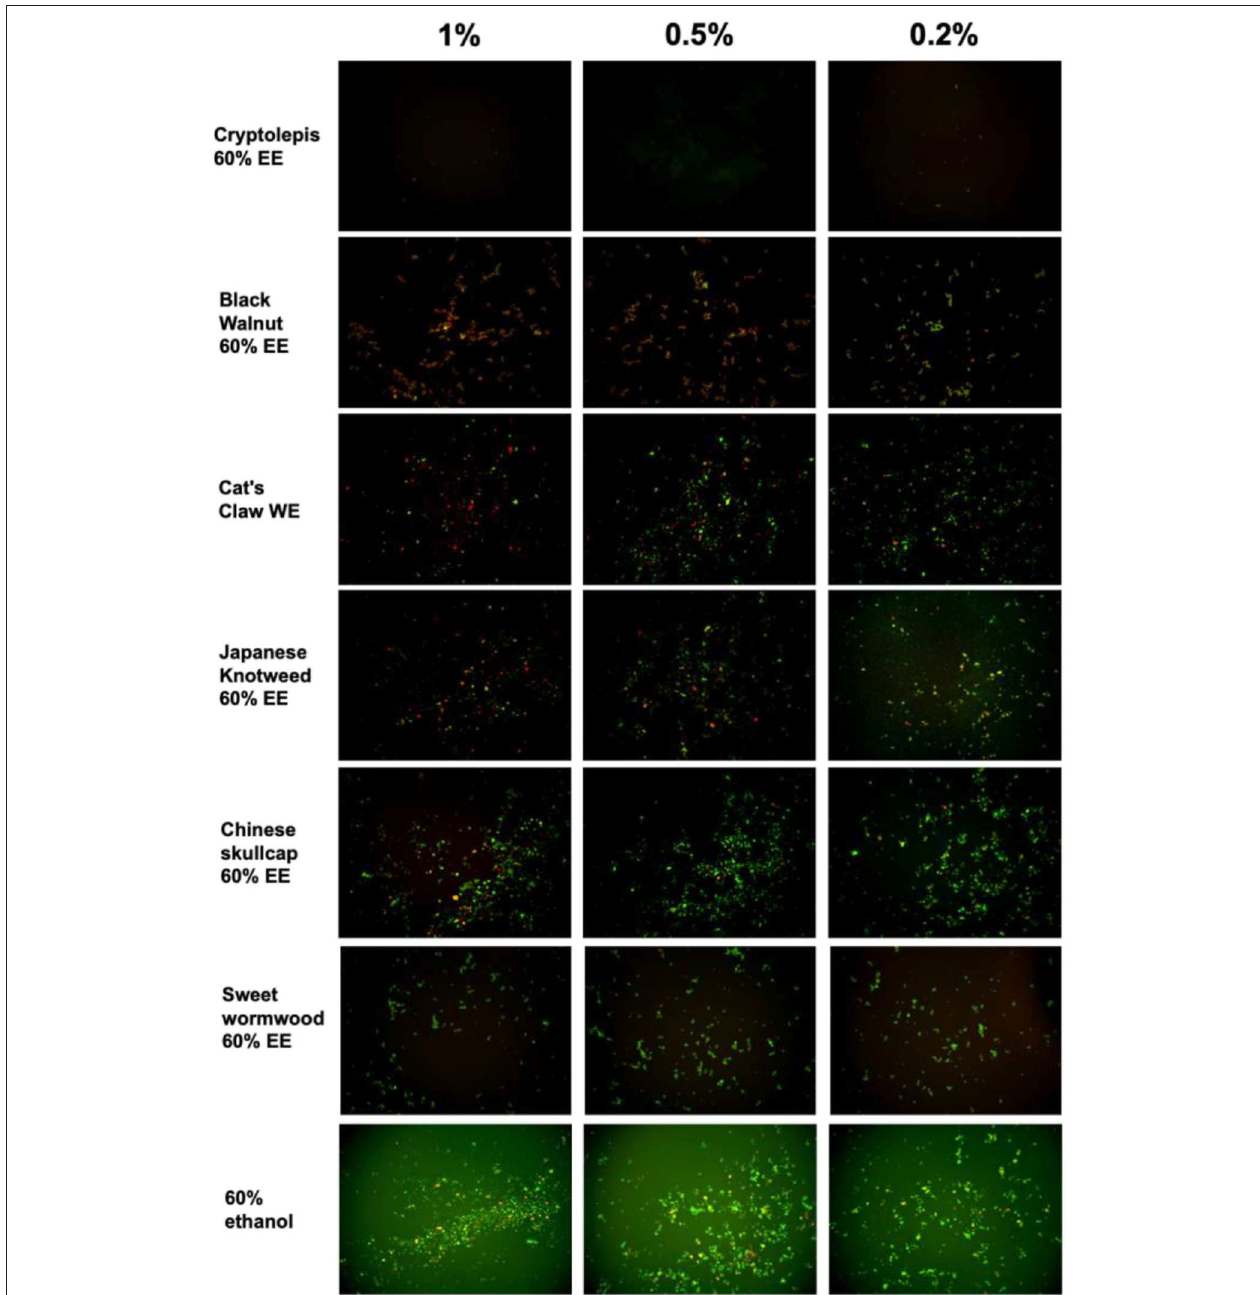
FIGURE 1 | Effect of natural product extracts on the viability of stationary phase B. burgdorferi. A 7-day old B. burgdorferi stationary phase culture was treated with the natural product extracts at 1, 0.5, and 0.2% for 7 days followed by staining with SYBR Green I/PI viability assay and fluorescence